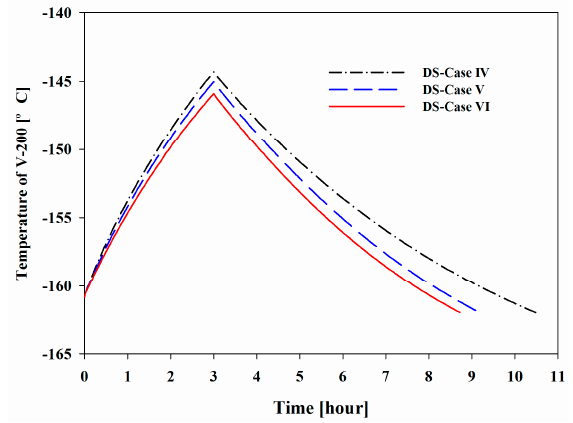
Figure 14. Temperature changes in V-200 with BOG composition.